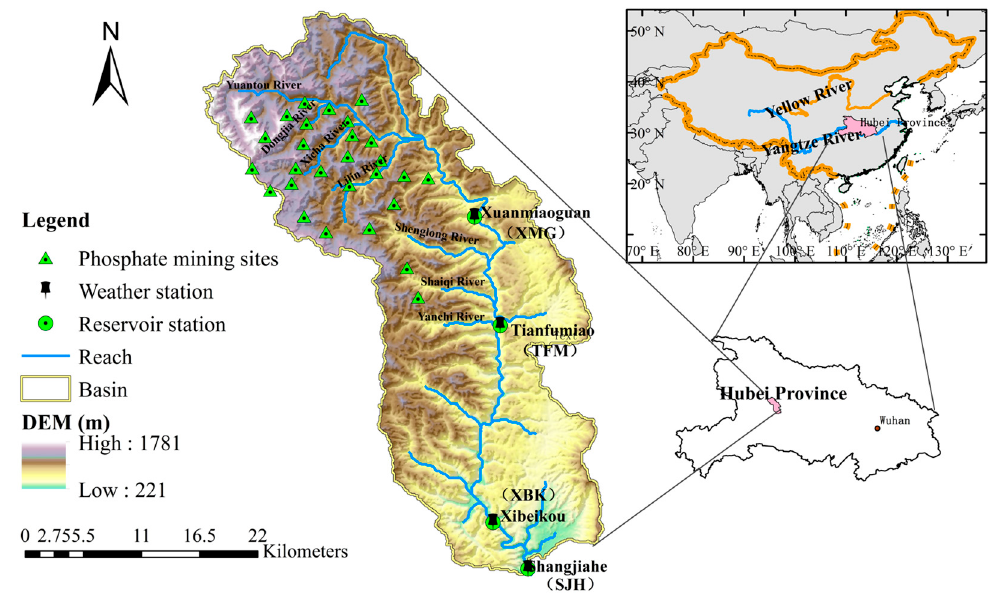
Figure 1. The locations of the Huangbaihe River Basin, reservoirs, weather stations and phosphate mining sites.